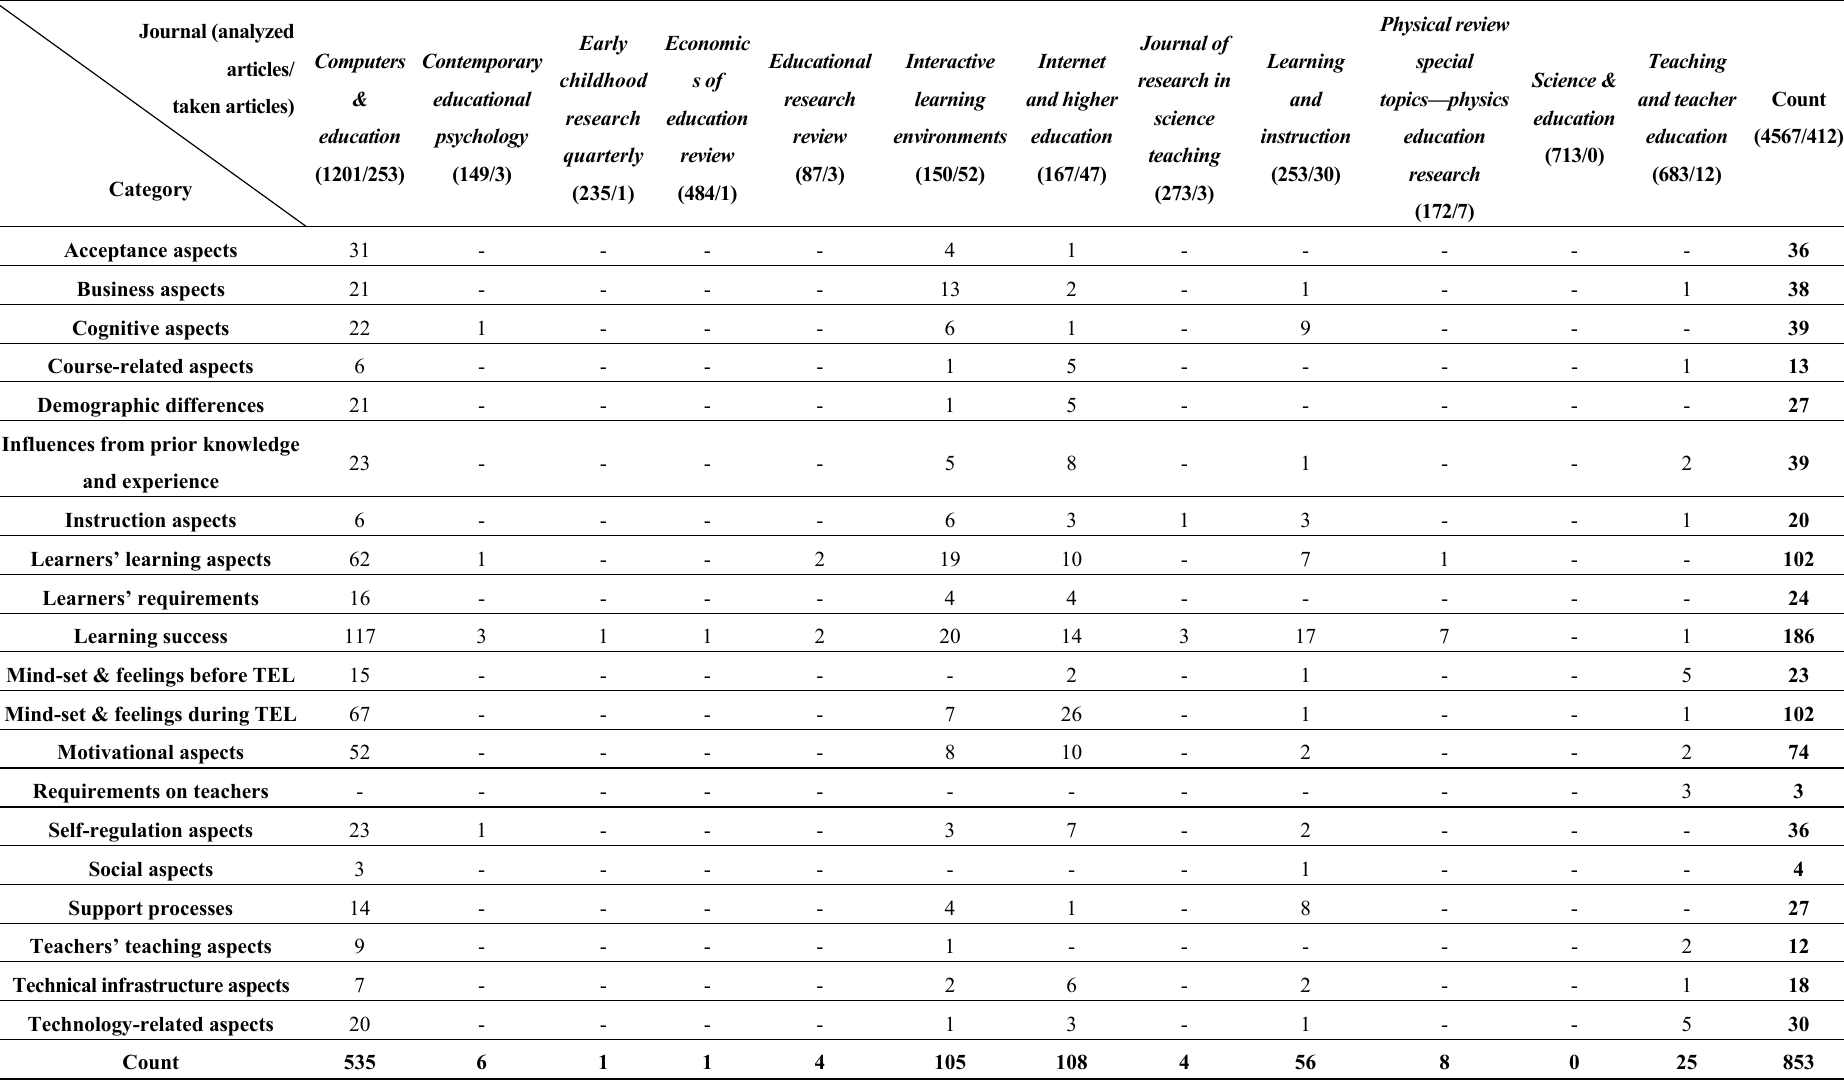
Table 1. Identified categories of aspects per